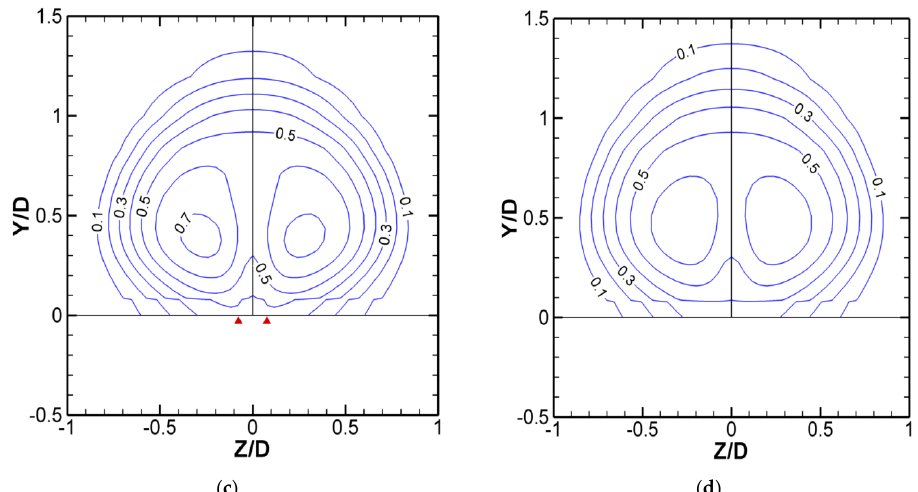
Figure 15. θ contours on Y-Z planes before reattachment. ( a ) X/D = 2; ( b ) X/D = 3; ( c ) X/D = 4; ( d ) At reattachment position.